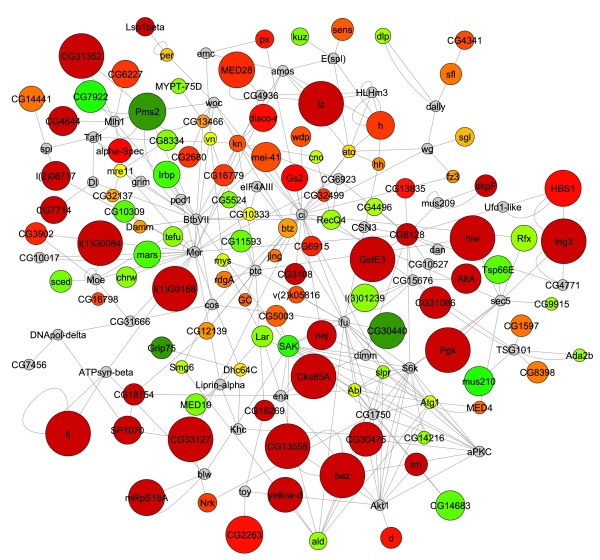
dFmr1 mutant active sub-network. Highest scoring sub-network found by jActiveModules using dFmr1 expression data. Red indicates genes that are up-regulated in dFmr1 compared to wild type and green indicates down-regulation. Yellow nodes represent genes with little to no change in expression and gray nodes represent genes that could not be assigned expression data. Node size indicates the significance (i.e. p-value) of the change in expression, where larger nodes are more significant and smaller nodes are less significant.